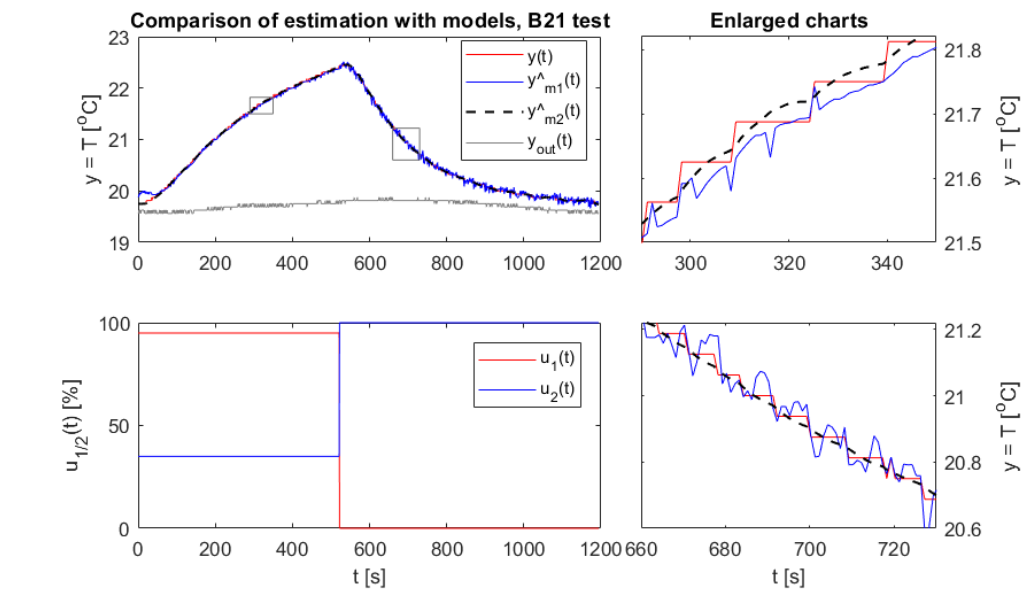
Figure 7. Experimental results for 500 particles; the measured value (red), estimated values from assumed models (blue and black), and outdoor measurement (gray); and the input